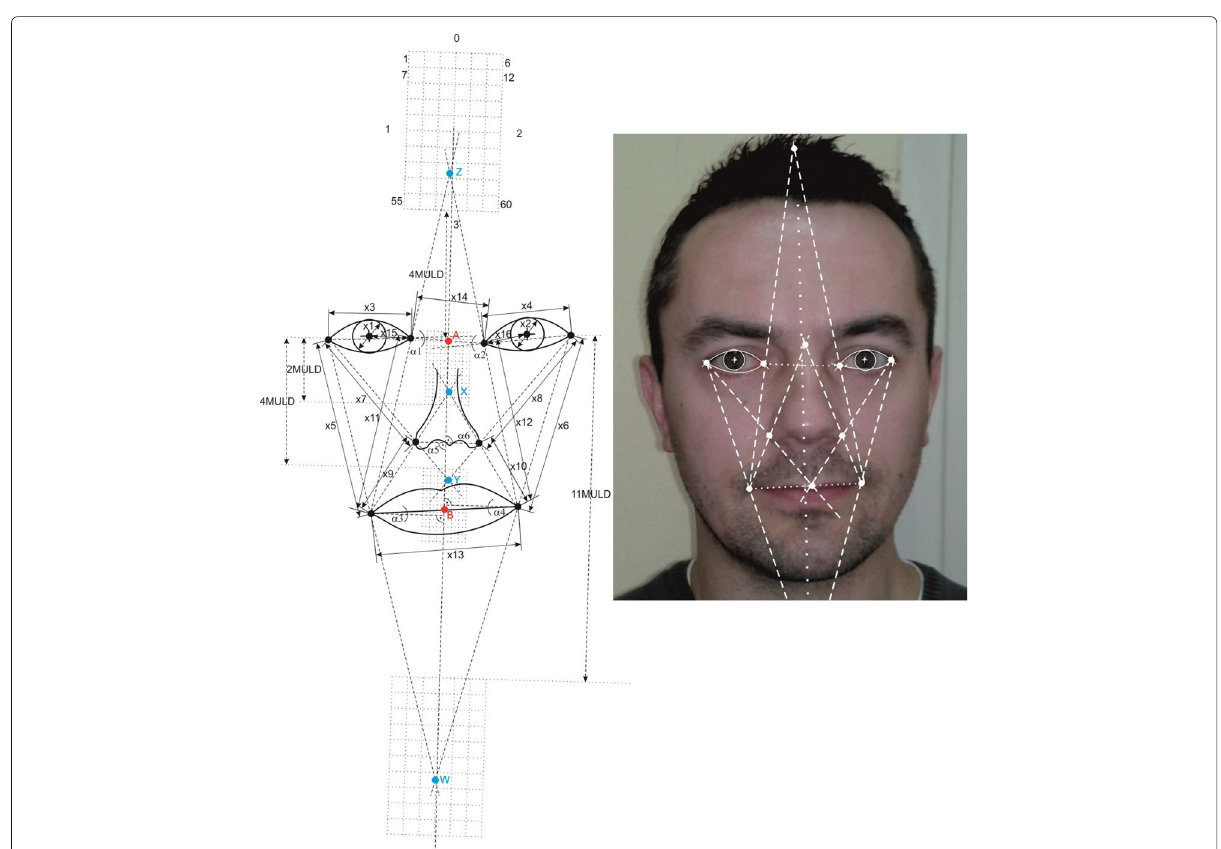
Fig. 9 Diagram of template creation of facial